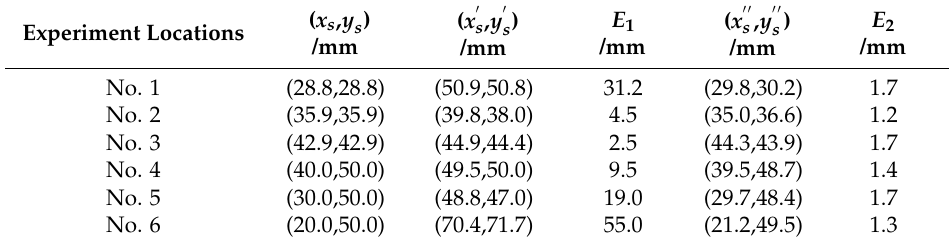
Table 3. Location results and their